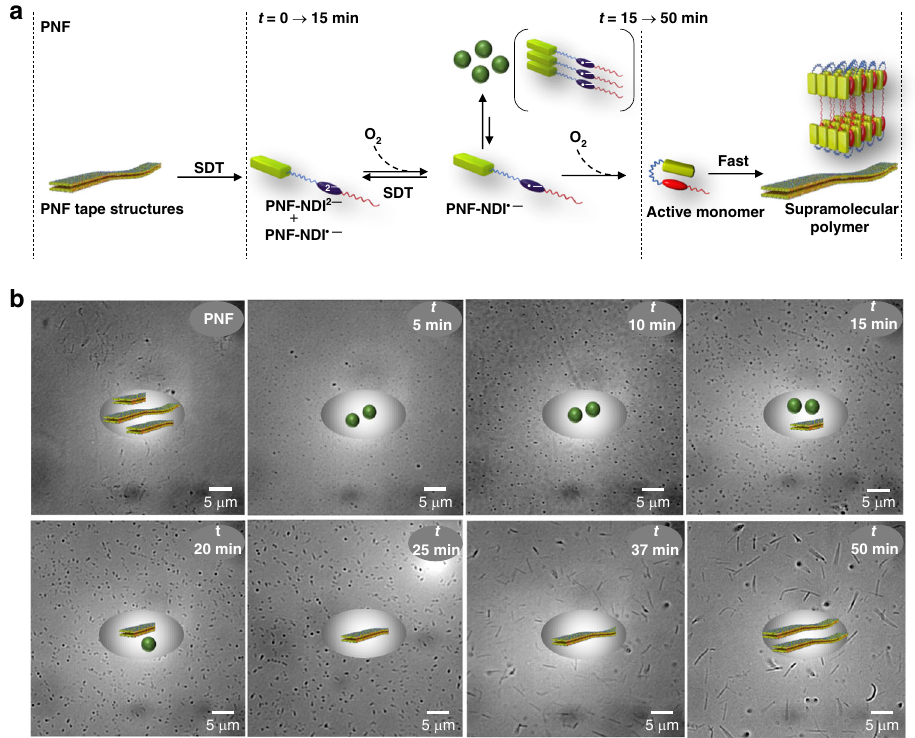
Fig. 5 Microscopic visualization of the kinetically controlled growth. a Schematic representation of various hierarchical changes during the redox mediated kinetically controlled growth of PNF supramolecular polymers. b Bright fi eld microscopic images captured at different time intervals depicting the evolution of the PNF tape structures from the spherical aggregates of PNF-NDI (cid:129) − assembly. Inset of each image shows the respective time point at which the images were captured along with the schematic of the corresponding structures present in the solution. [PNF] = 5 × 10 − 5 M, CH 3 CN/H 2 O (1:1 v/v), pH = 8,